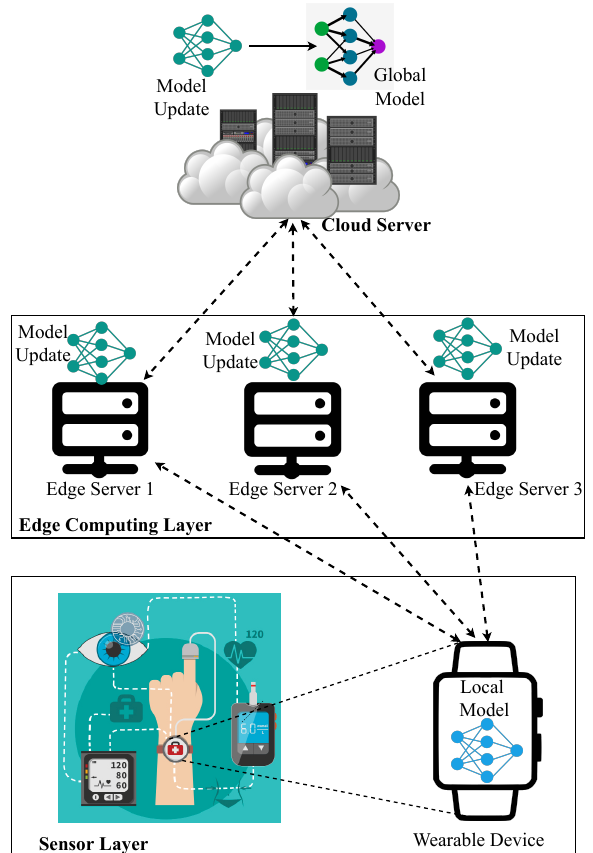
Figure 1. FL-PMI architecture for predicting a person’s accurate movement in a SHC